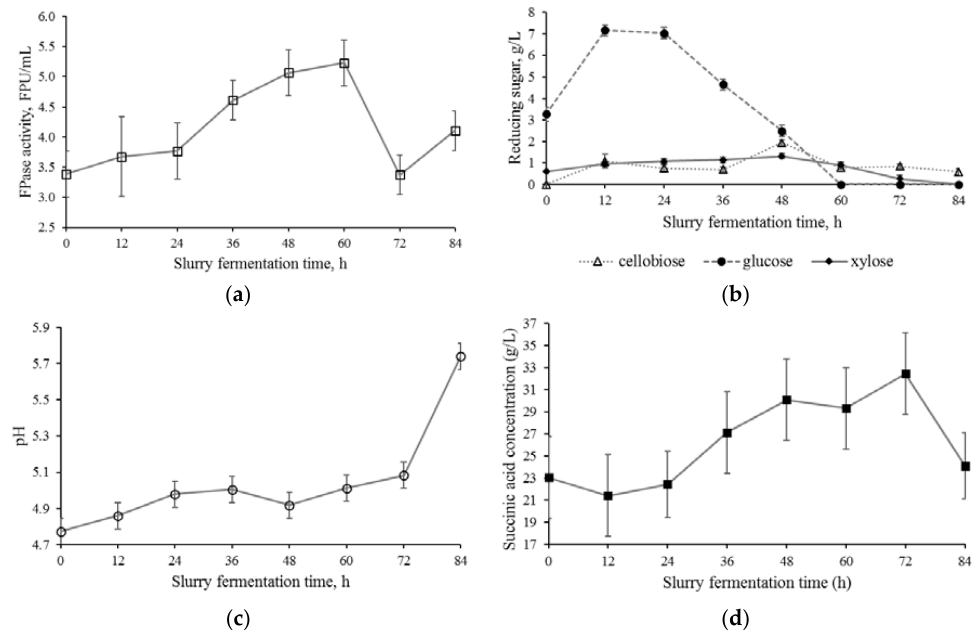
Figure 3. Time profiles of ( a ) filter paper cellulase activity, ( b ) residual sugars, ( c ) pH, and ( d ) succinic acid concentration from a mixed culture of Trichoderma reesei , Aspergillus niger , and Phanerochaete chrysosporium on 3:1 birch wood chip–soybean hull biomass during 84 h of slurry fermentation. Error bars represent pooled standard deviations in the data sets.